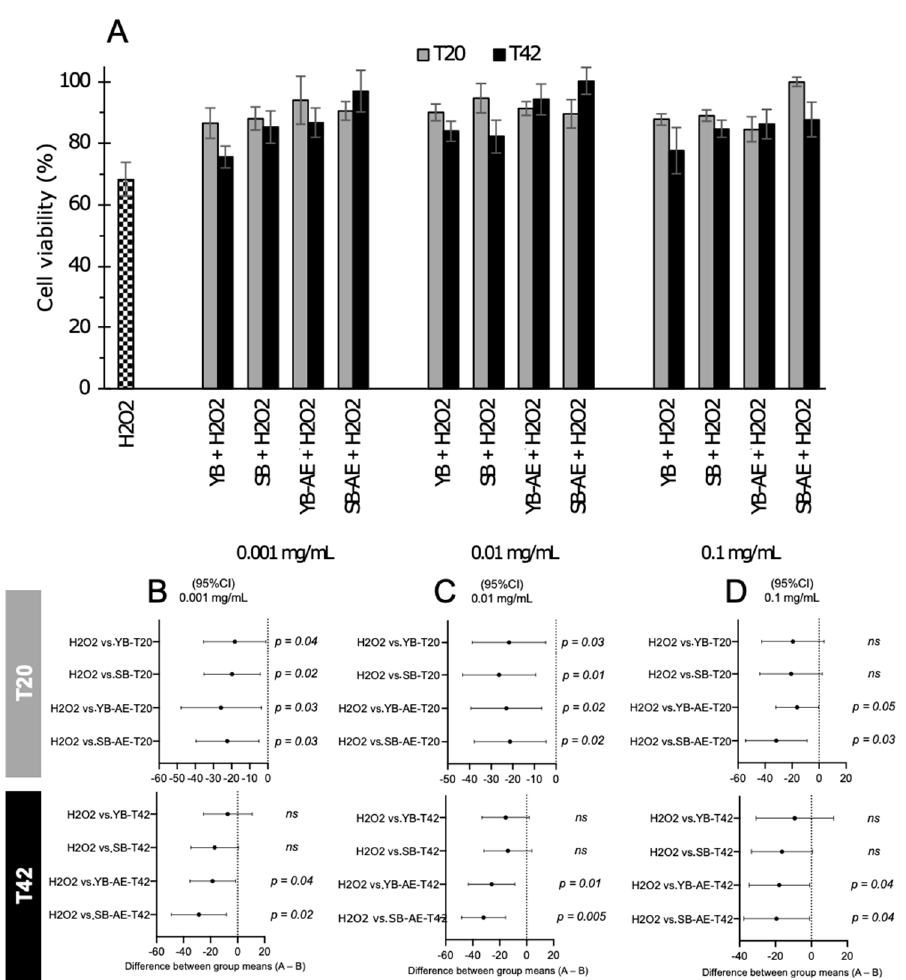
Figure 5. Protective e ff ect of digested bread on human keratinocyte cell viability against oxidative stress induced by hydroxide peroxide (H 2 O 2 ). Bread batches were prepared with or without type-II sourdough (YB and SB, respectively) and with or without a powdered artichoke leaf extract (AE). Supernatants from fecal batches derived from fermented bread digestion were recovered at di ff erent times (20 and 42 h, T20 and T42, respectively) and tested at di ff erent concentrations (0.1–0.001 mg/mL). The 100% of cell viability corresponded with values of cells cultured in the medium under optimal conditions. The viability of cells exposed to the H 2 O 2 stressor agent is reported ( A ). Data are mean values of three independent experiments analyzed twice. Error bars are shown in the bar plot. The protective role accounted for a signi fi cant di ff erence ( p -values < 0.05, one-way ANOVA test) between cells exposed to the H 2 O 2 stressor agent and cells incubated with di ff erent concentrations of supernatants in the culture medium (0.001, 0.01, and 0.1 mg/mL: ( B – D ), respectively). ns , not signi fi cant.